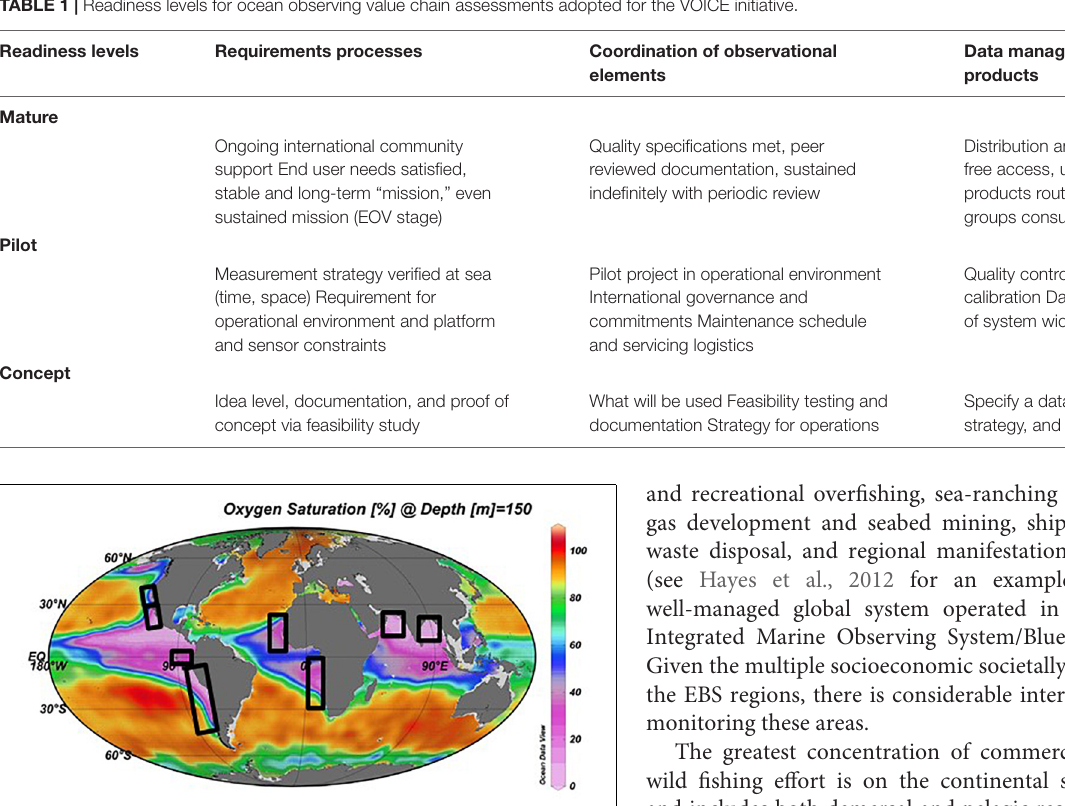
FIGURE 2 | Location of selected VOICE regions overlain on top of the global map of annual oxygen saturation (%) at 150 m depth. Regions included in VOICE: the oxygen minimum zone/eastern boundary systems (EBSs) (OMZ/EBS), the California Current System (US West coast and the